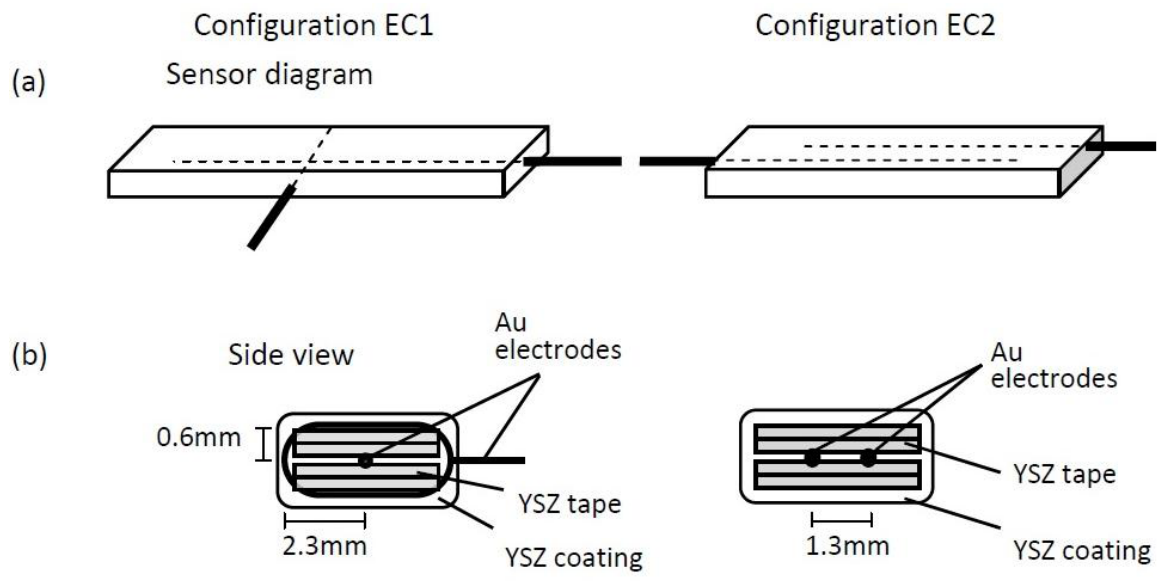
Figure 1. Diagrams of the NO sensors with electrode configurations ( a ) EC1 and EC2; ( b ) Cross sectional view illustrating the placement of the Au electrodes within the YSZ tape layers composing the